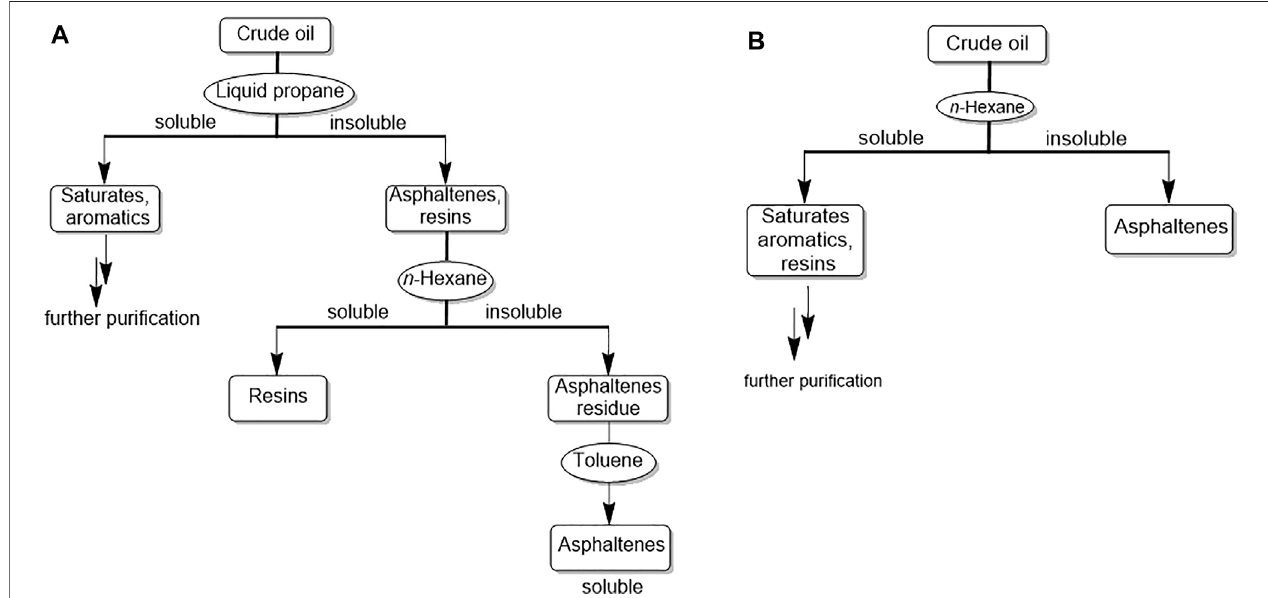
FIGURE 1 | (A) : Strategy for separation of oil components [saturates, aromatics, asphaltenes and resins (SARA)], adapted from Fakher et al., 2020 (B) Commonly used strategies for the separation of asphaltenes from the rest of the oil components, used in many publications discussed in this review.